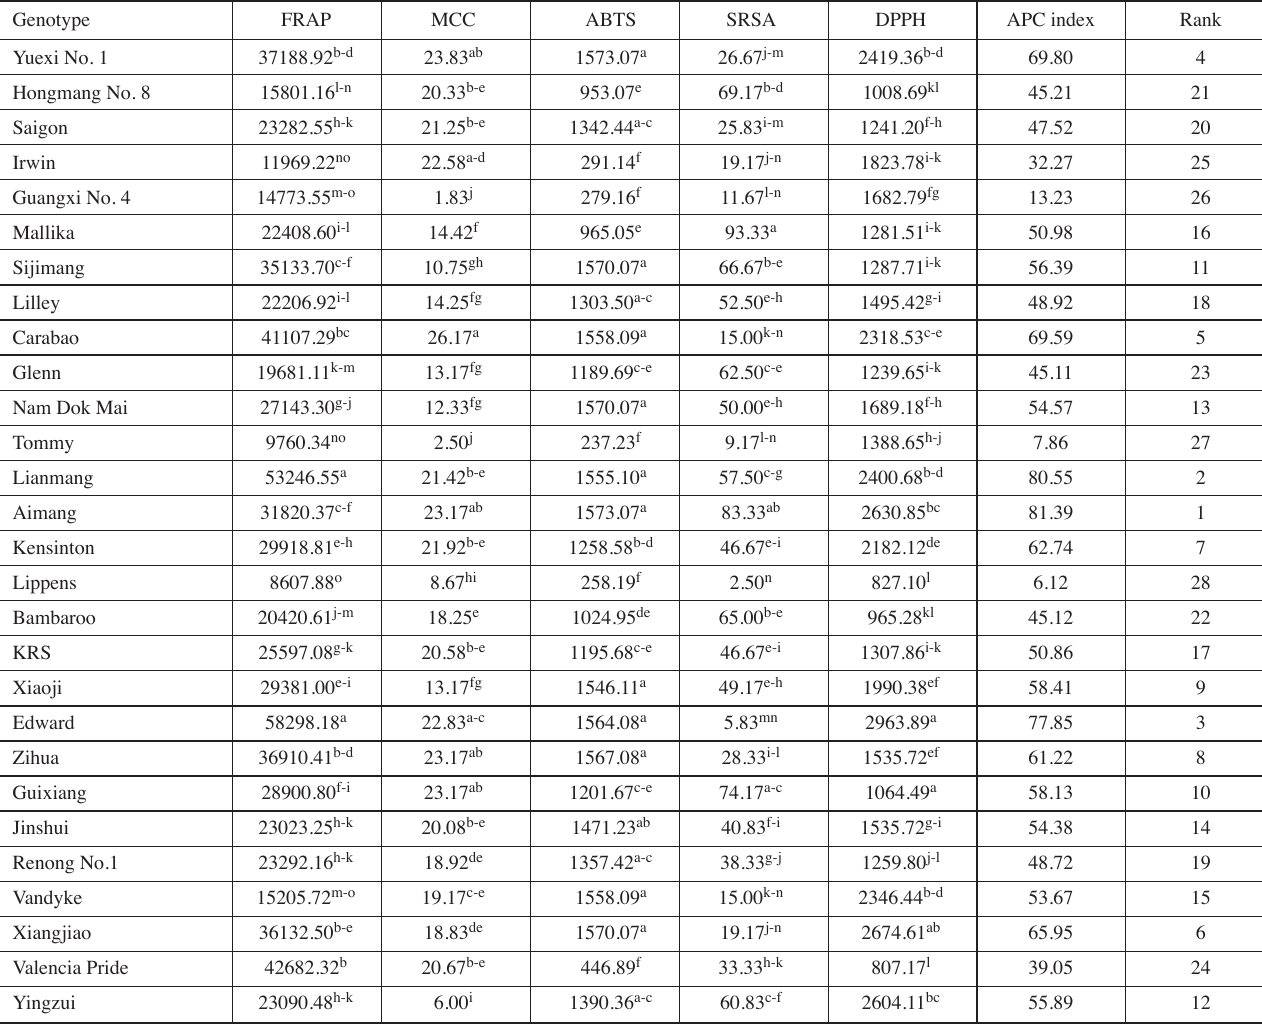
Different superscript letters indicate significant differences across genotypes at p <